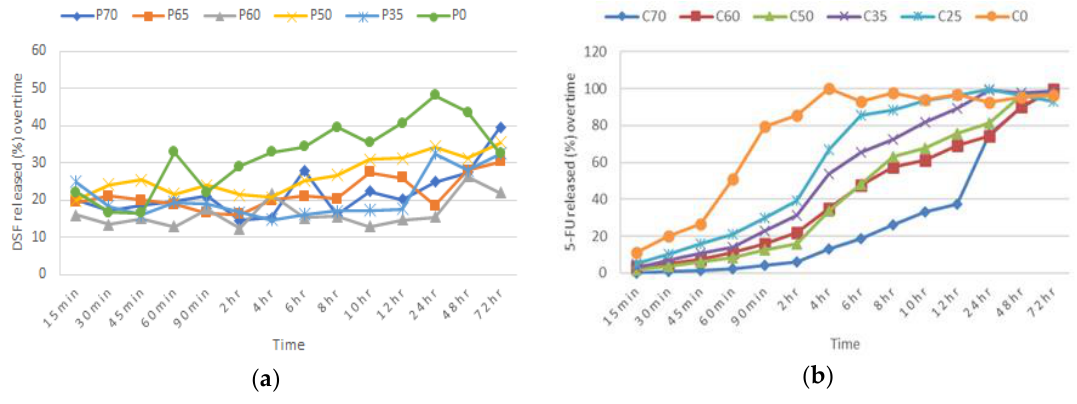
Figure 1. Cumulative percentage of drug released from batches of ( a ) Blend 1 and ( b ) Blend 2.